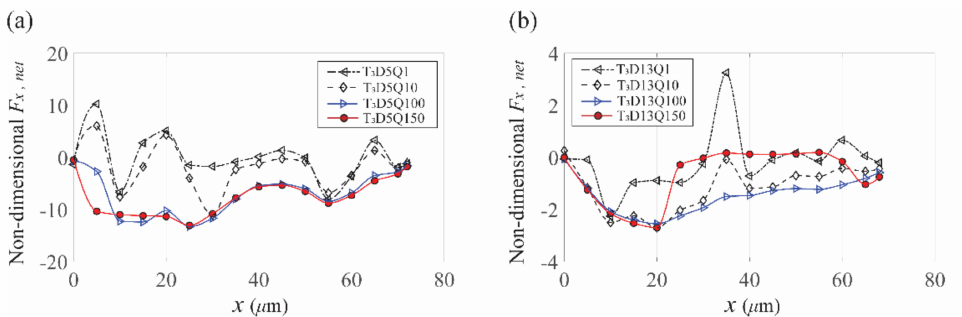
Figure 10. Variation in x-directional net elasto-inertial force exerted on ( a ) 5 µ m and ( b ) 13 µ m particles suspended in the Type 3 channel. Measurements were made for various particle locations along the x axis illustrated in Figure